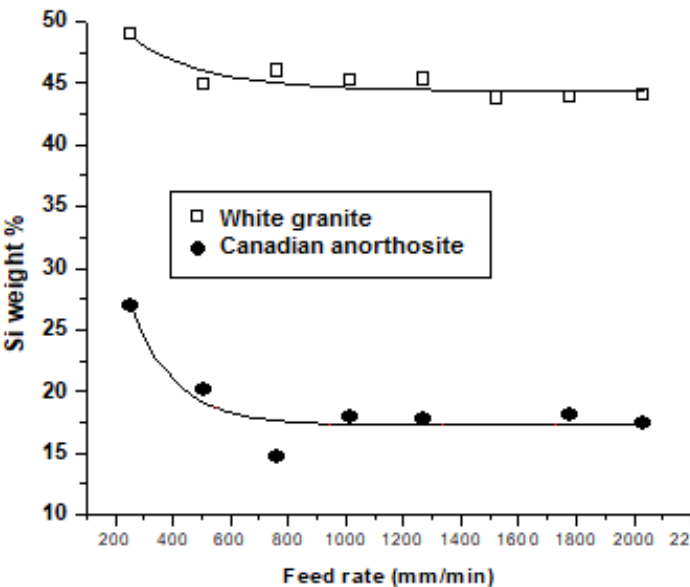
Figure 12. Variation of Si weight percent in emitted particles at different feed rates for the tested stones (polishing speed—1000 rpm; grid size—60; pressure—0.2 bar).